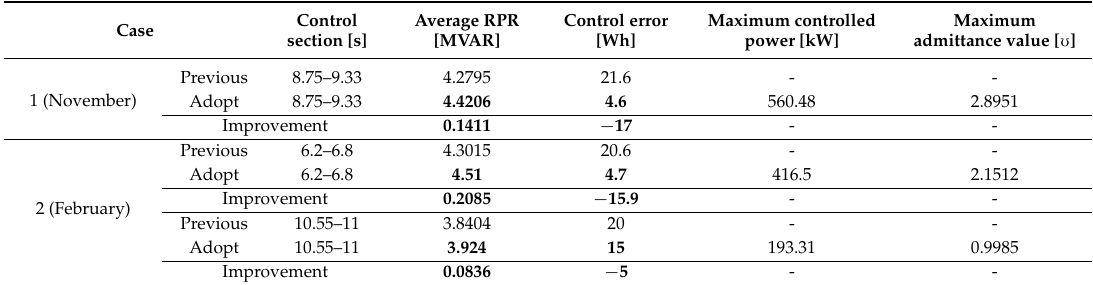
Table 4. Numerical results of the simulations. Volt-ampere reactive: